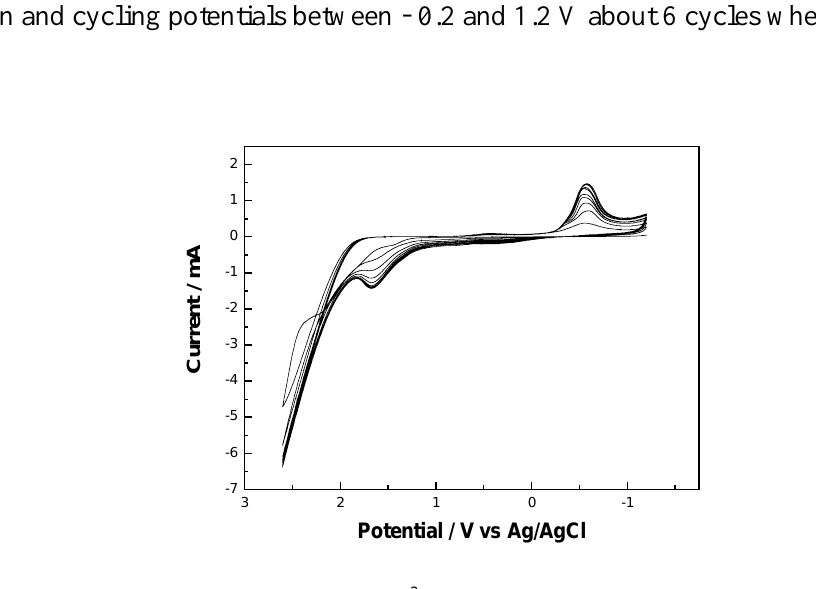
Figure 1. Cyclic voltammograms of 2.5 × 10 − 3 M L -cysteine at a glassy carbon electrode in 0.04 M HCl solution. Scan potential: - 1.2 to 2.6 V; scan rate: 100 mV·s − 1 .